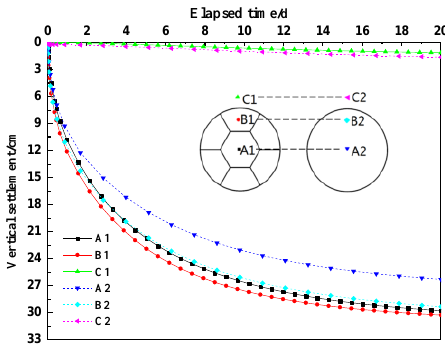
( c ) Vertical settlement of the soil versus elapsed time Figure 5. Vertical settlement of the soil.. Figure 5. Vertical settlement of the